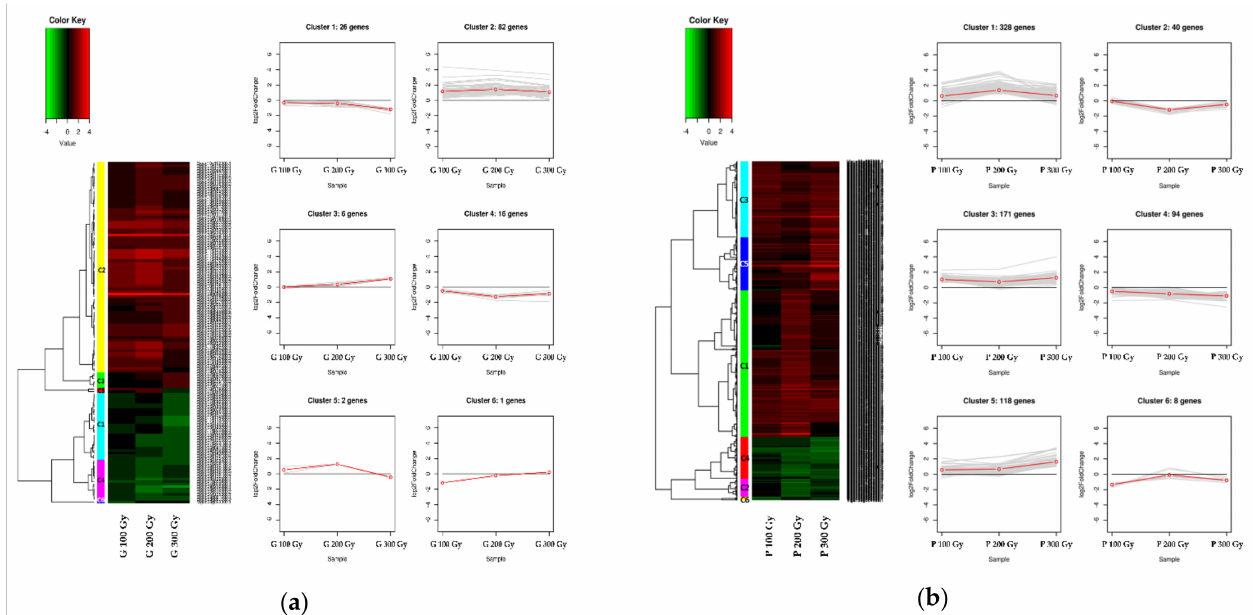
Figure 5. As a result of clustering analysis, heatmaps showing the level of differential expression of genes in each cluster. ( a ) Gamma-ray treatments; ( b ) proton-beam treatments. The line plot is a pattern representing the clusters expressed in the heatmaps. Up or down-regulated ranges from black to red (or green) with a fold-change scale bar shown above the